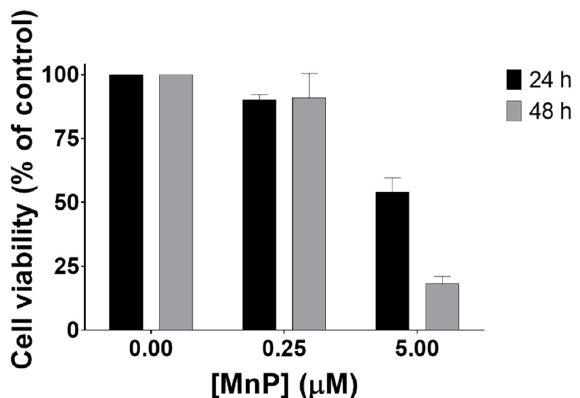
Figure 2. Cell viability of 786-O cells exposed to MnP (0.25 and 5 μM), using 10% FBS. The cell viability of MnP-exposed cells (24 and 48 h) was evaluated by CV assay. Values represent mean ± SD (n = 3) and are expressed as percentages of the non-treated control cells.